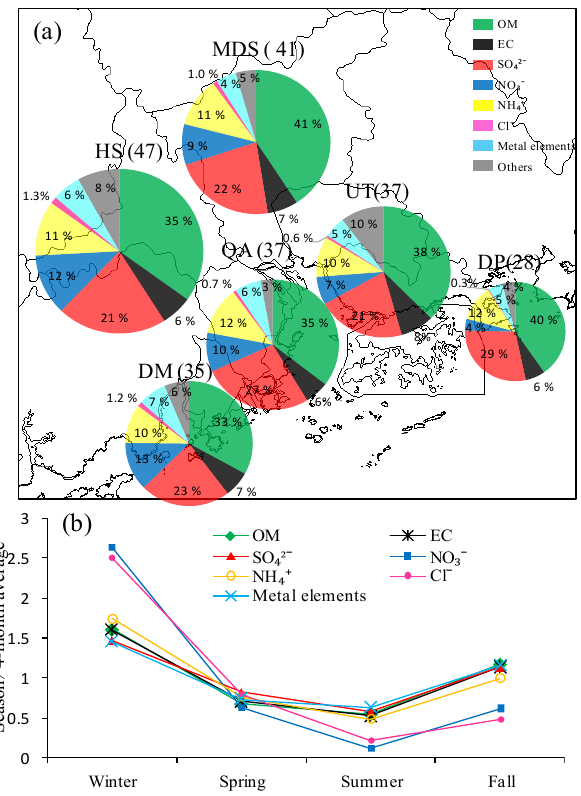
Figure 3. The spatial distributions of (a) and seasonal variations in (b) the PM 2 . 5 chemical compositions in the PRD. Sizes of the pie charts indicate the concentrations of PM 2 . 5 at the six sites, with the detailed numbers (unit: µgm − 3 ) in